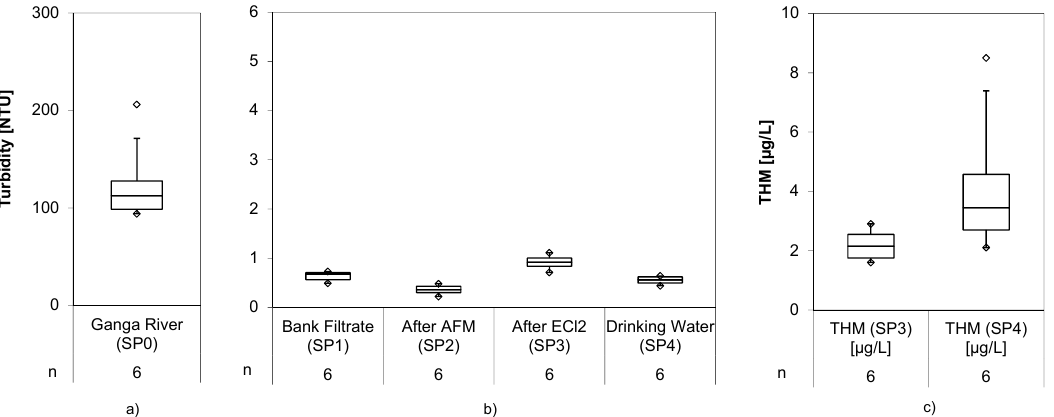
Figure 13. Turbidity removal ( a , b ) and THM formation ( c ) during short term test with optimized system setting.